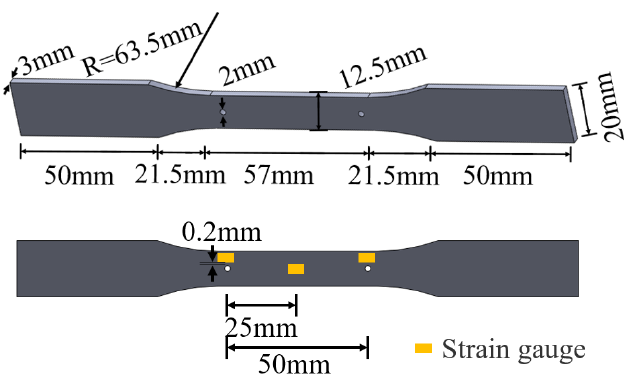
Figure 3. Strain gauges arrangement, unit: mm.